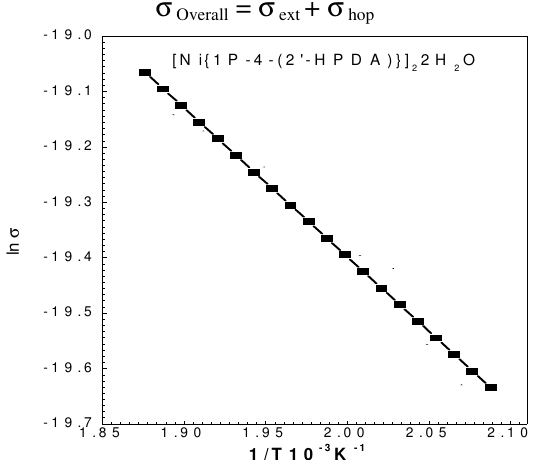
Figure 1. Temperature dependence of electrical conductivity (The electrical conductivity of Ni[{1P-4-(2' HPDA)}]